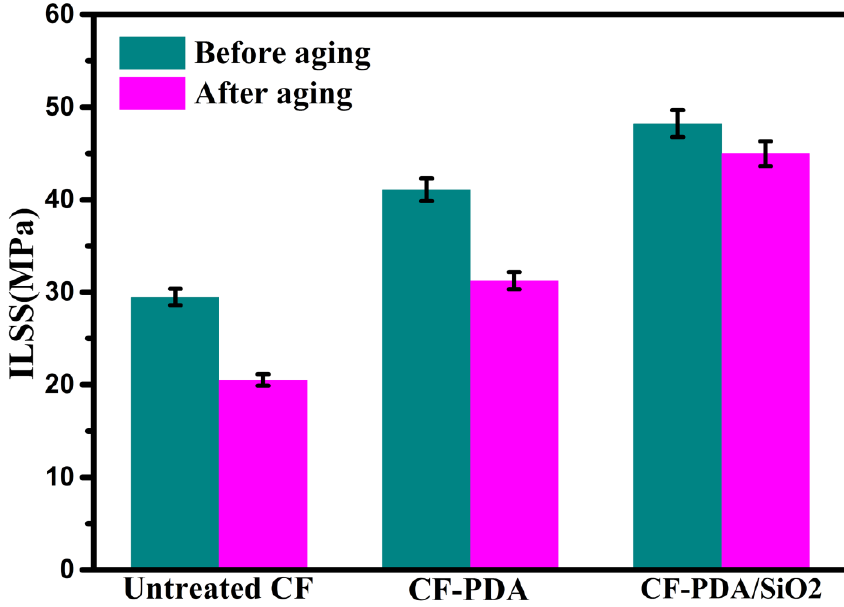
Figure 3. ILSS of composites before and after hydrothermal aging treatment.